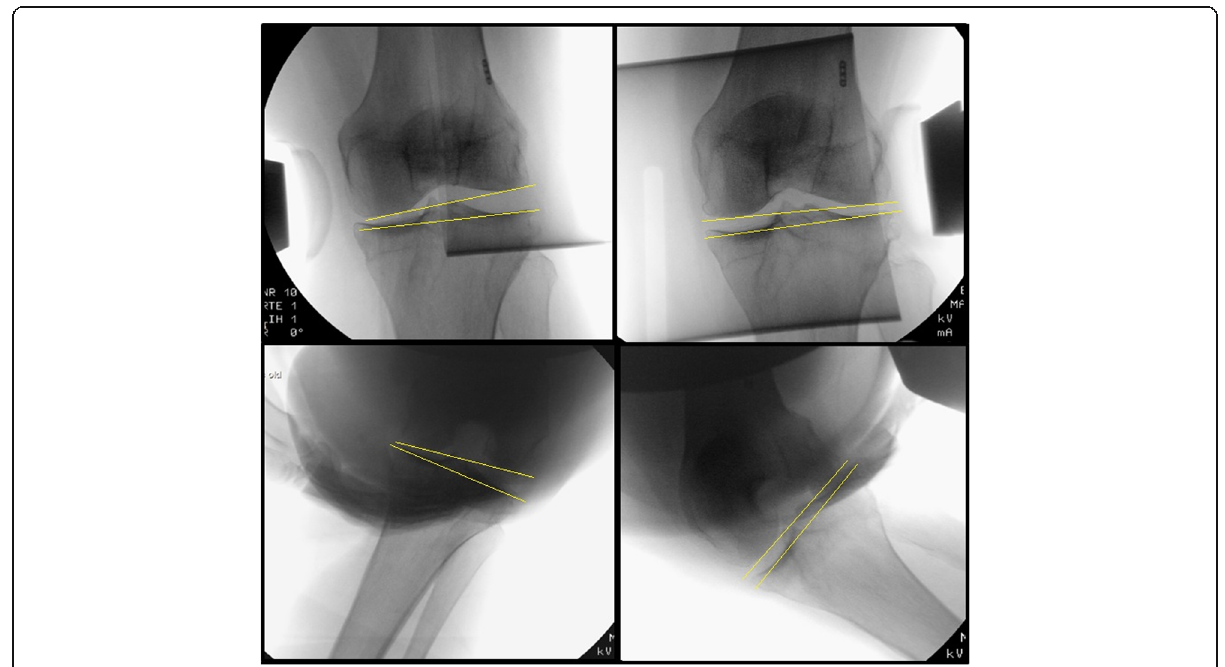
Fig. 2 Valgus and varus laxity stress radiographs with joint space opening. Subscript: Pre-operative stress radiographs of the knee in 30° and 70° of knee flexion in an anaesthetized patient. The upper two figures show radiographs in 30° of flexion with varus (left) and valgus (right) stress. The lower two figures show radiographs in 70° of flexion in varus (left) and valgus (right) stress. The angle between a tangent line on the femur condyles and a line through the deepest tibial joint surfaces was determined and compared to the natural (unstressed) knee joint line congruence angle